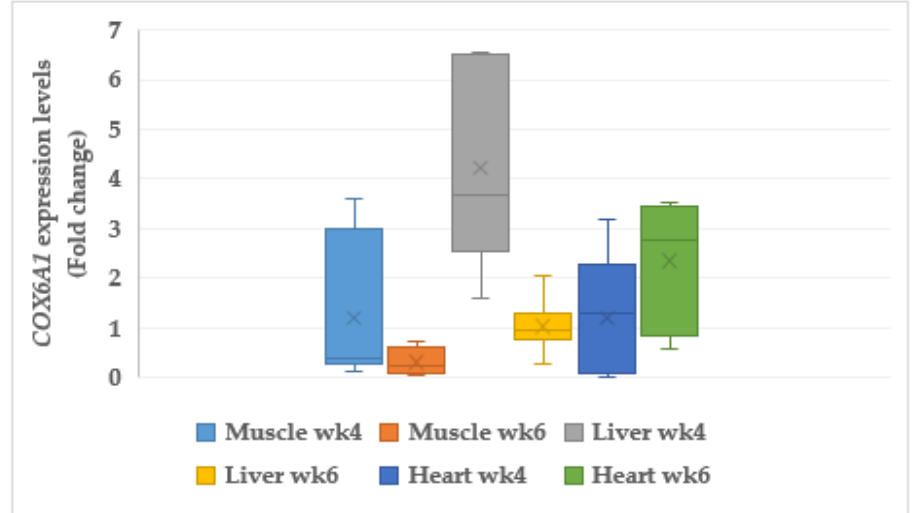
Figure 3. Expression profiles of mitochondrial cytochrome C oxidase ( COX6A1 ) in the muscle, liv- er, and heart at week 4 and 6 in corticosterone-fed chickens (fold-change). wk4 = 4 weeks of age (2 weeks of CORT administration; wk6 = 6 weeks of age (4 weeks of CORT administration); n = 20.